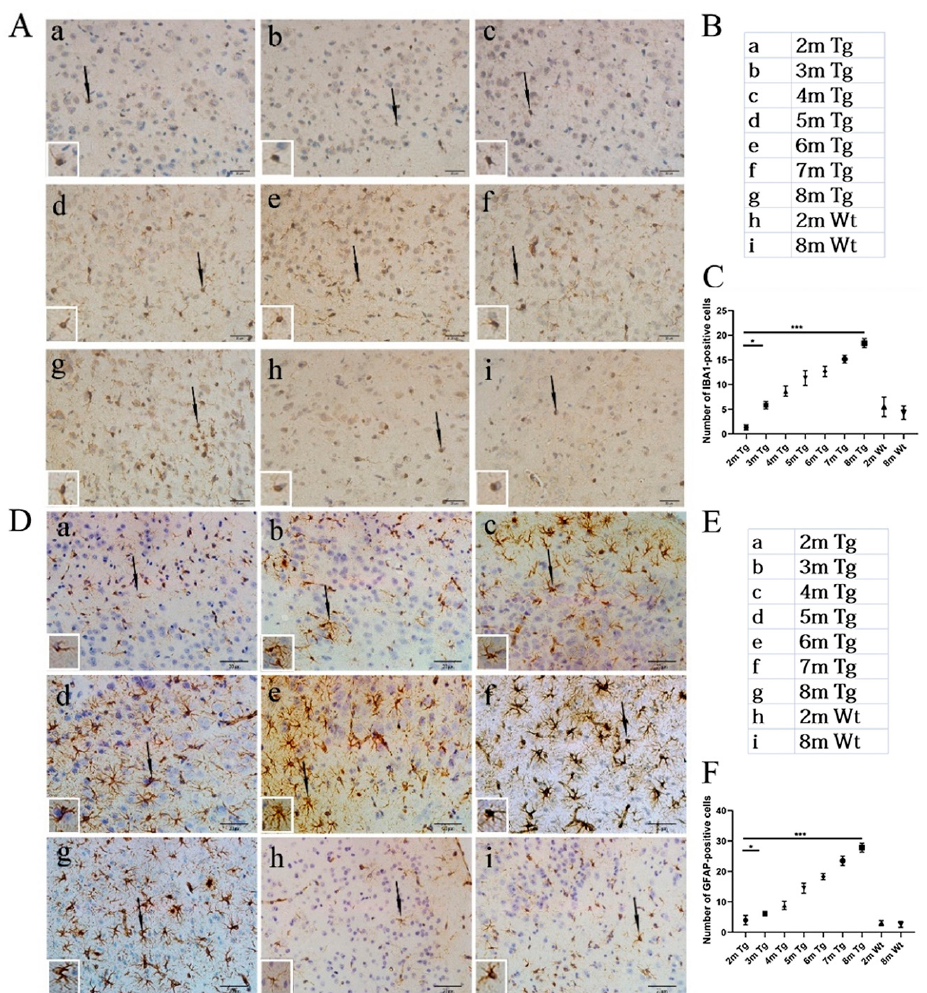
Figure 2. Age-related changes in the microglia and astrocytes in the entorhinal cortexes of the APP/PS1 and Wt mice. ( Aa – g ) Microglia in the entorhinal cortexes of the APP/PS1 mice at 2–8 months. ( Ah , i ) Microglia in the entorhinal cortexes of the Wt mice at 2 and 8 months. ( B ) The details of the sample groups. ( C ) Quantitative statistical analysis of microglia quality. ( Da – g ) Astrocytes in the entorhinal cortexes of the APP/PS1 mice at 2–8 months. ( Dh , i ) Astrocytes in the entorhinal cortexes of the Wt mice at 2 and 8 months. ( E ) The details of the sample groups. ( F ) Quantitative statistical analysis of astrocyte quality. Scale bar = 20 µ m. All values are presented as the means ± SDs from three independent experiments. *** p < 0.001, ** p < 0.01, and * p < 0.05. n = five mice per group.